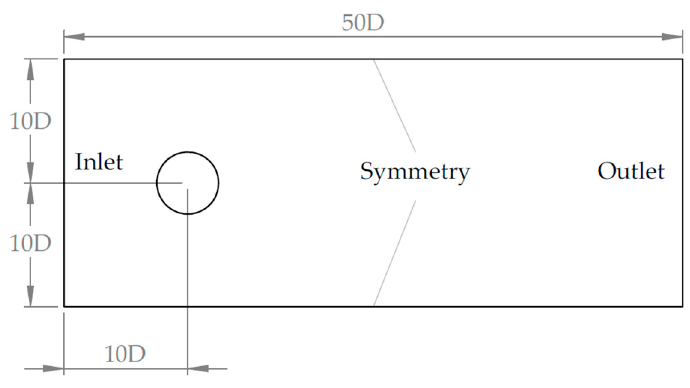
Figure 2. Computational domain dimensions (not to scale).